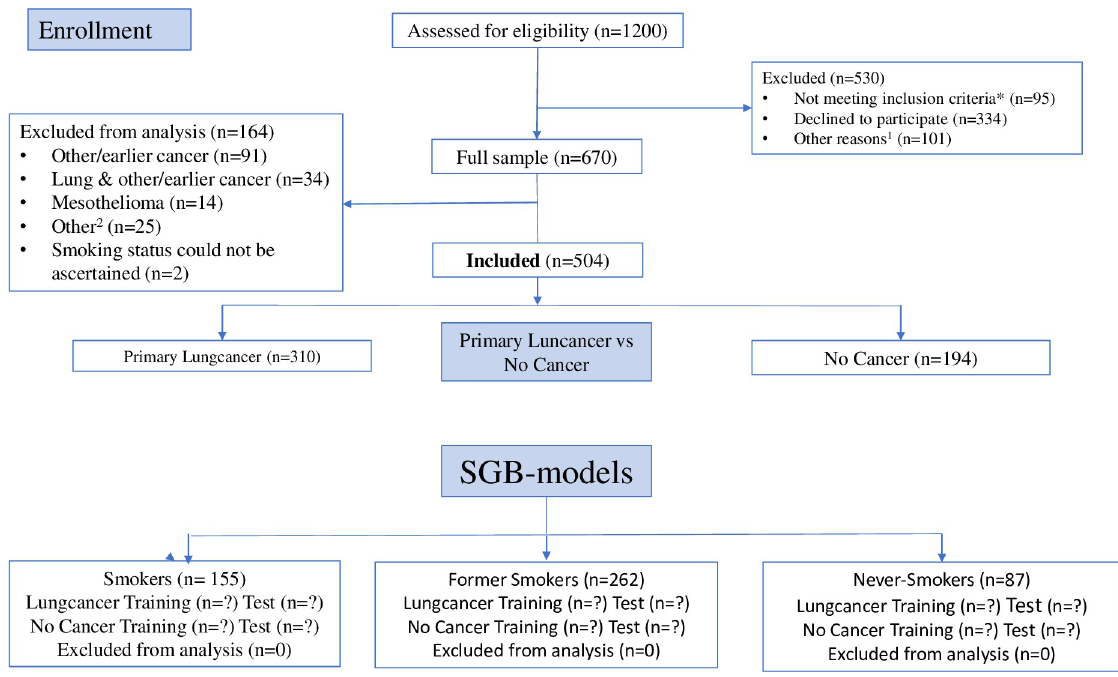
Fig 1. CONSORT flow diagram: The PEX-LC lung cancer investigation cohort. This figure is based on the CONSORT 2010 flow diagram. As this was not a randomised intervention trial, it has been modified to suit this cohort study accordingly. Primary lung cancer (no other cancer); NSCLC: non-small cell lung cancer (adenocarcinoma, n = 200; squamous cell carcinoma, n = 45; not otherwise specified (NOS), n = 5; other NSCLC (adenosquamous lung carcinoma (n = 4), large cell neuroendocrine carcinoma (n = 3); large cell carcinoma, adenoid cystic carcinoma of the lung, adenoid carcinoma with neuroendocrine differentiation, and mucoepidermoid carcinoma of the lung (n = 1, respectively)); SCLC: Small cell lung cancer (includes one individual with combined SCLC) (n = 24); Other LC: carcinoid, n = 9; no histology, n = 17. � Not meeting inclusion criteria: translator required (n = 50), consent withdrawn/missing (n = 15); missing data (n = 5); other reason such as or pain, illness, or other medical condition (n = 25). 1 Other reasons: Limited time of the visit or lack of resources (staff) at the clinic (n = 47); hospitalisations (n = 34); deaths (n = 20). 2 Other: Medical records non-consent (n = 4); unconfirmed, possible lung cancer (n = 3); undiagnosed cancer (n = 2); death before clinical investigation (n = 1); participant withdrew clinical investigation (n = 2); previous lung cancer (n = 1); incomplete modules (n =